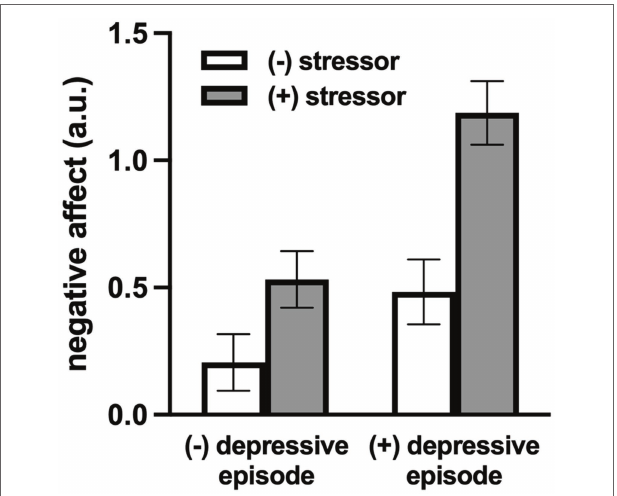
FIGURE 2 | Model-estimated negative affect (NA) for individuals with and without a depressive episode, on COVID-19-specific stressor and non-COVID-19-specific-stressor days. NA was greater on days with an exposure to a COVID-19-specific daily stressor in adults with a depressive episode but not in those without. Data are mean ±